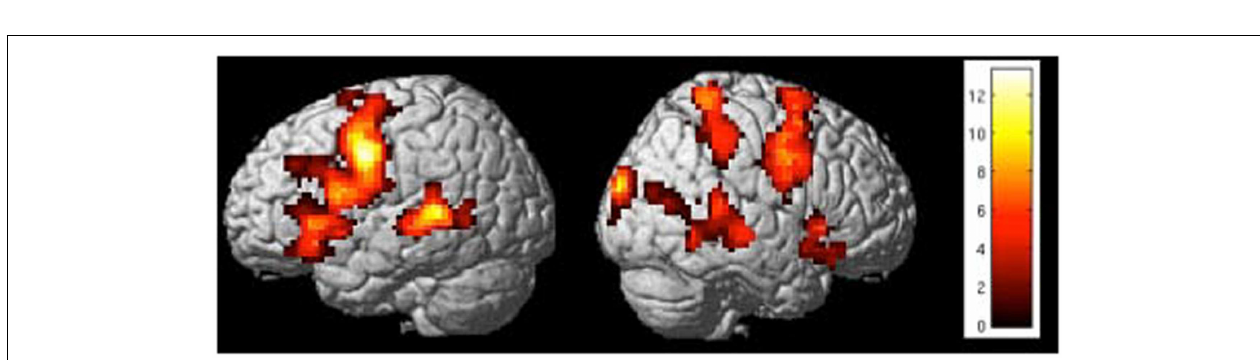
FIGURE 7 | “Functional connectivity across three sessions of training in a representative subject.” Y -axis represents the F -value for the connection between IFG and posterior STG under the autoregressive model, based on Granger causality analysis.